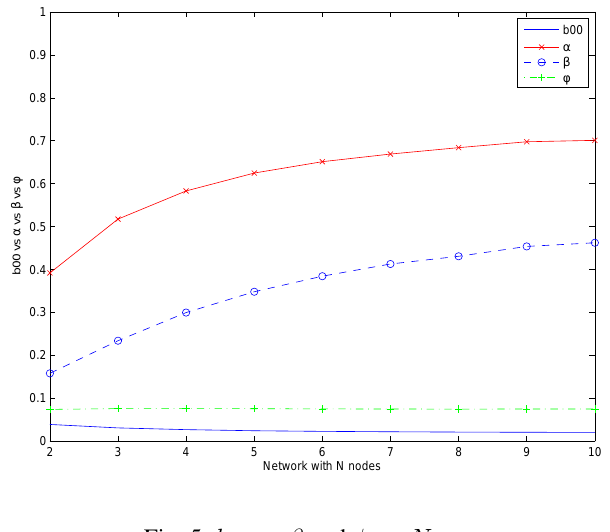
Fig. 5. b 00 , α , β and φ vs.